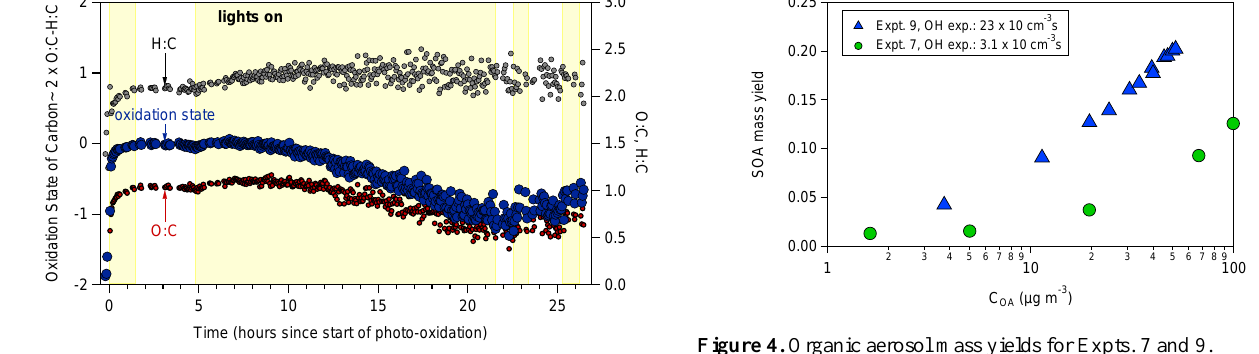
Figure 3. Time series of carbon oxidation state (left axis) and ele- mental ratios of O : C and H : C (right axis) for Expt. 3. The periods during which the reactor was dark are shown in with white back- ground while the periods with UV lights are shaded yellow.